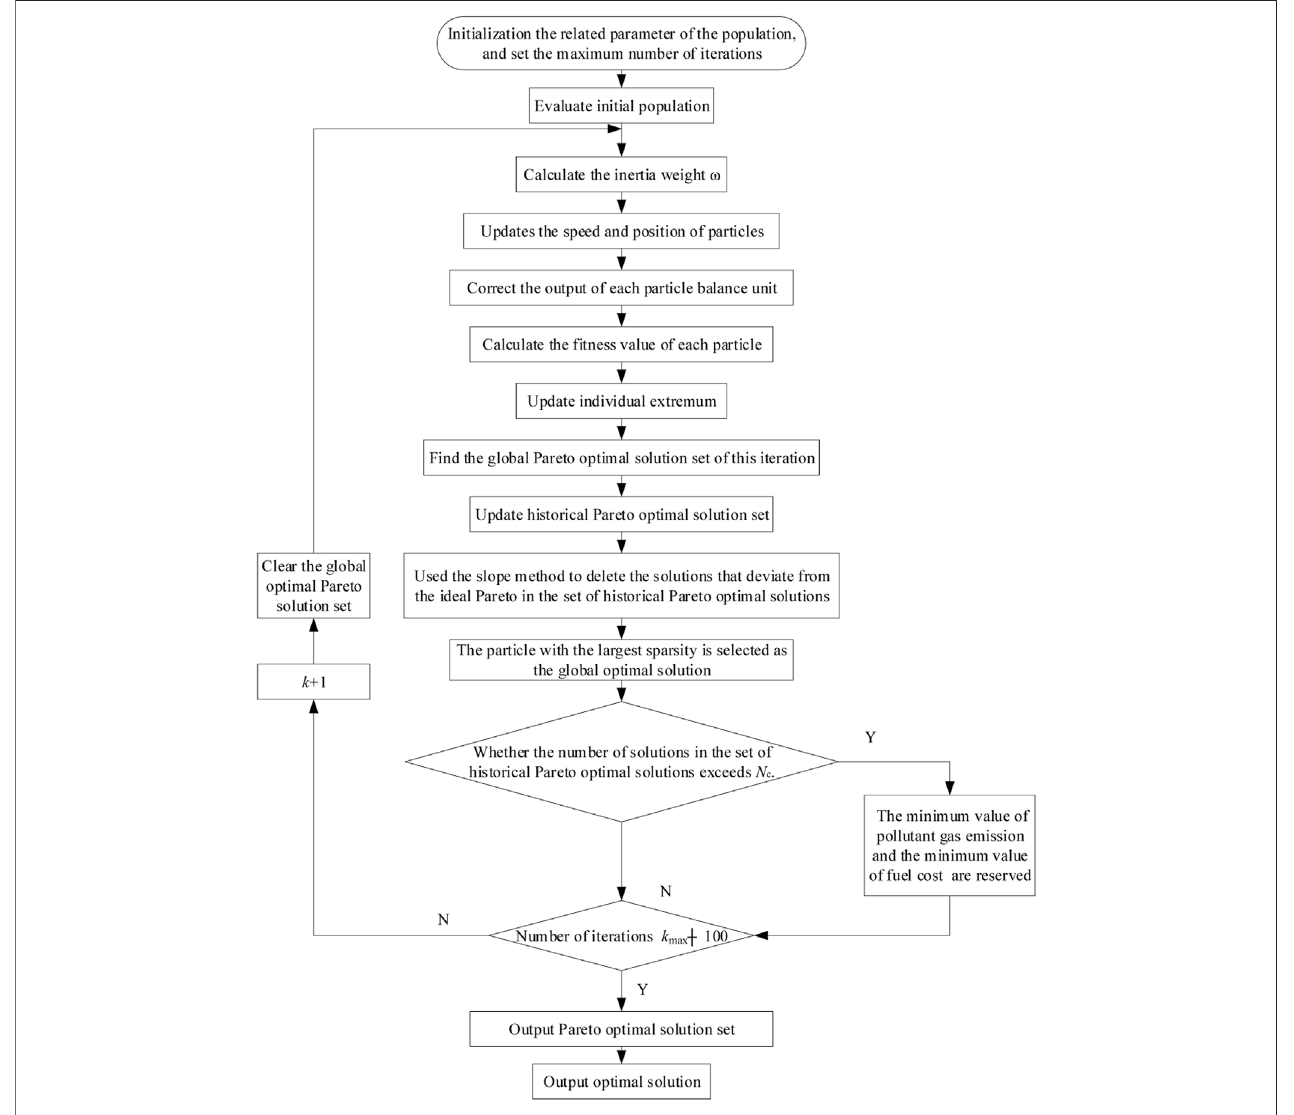
FIGURE 4 | Computational fl owchart of the proposed method.